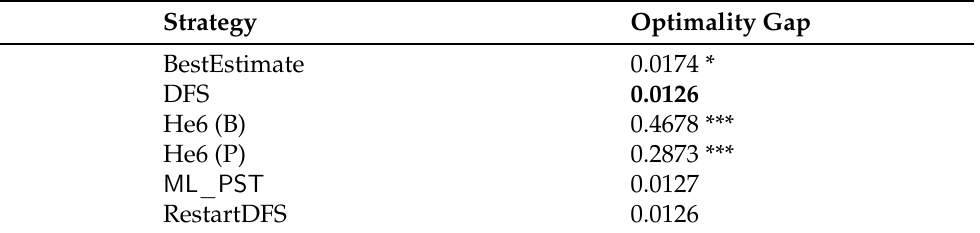
Table A6. Combinatorial auctions: model with on_both = PrioChild, on_leaf = Score and prune_on_both = True against baselines, with equal time limits for each problem. The initial optimality gap obtained by the solver before branch-and-bound is 0.914. Pairwise t -tests against the ML policy: ‘***’ p < 0.001, ‘*’ p <